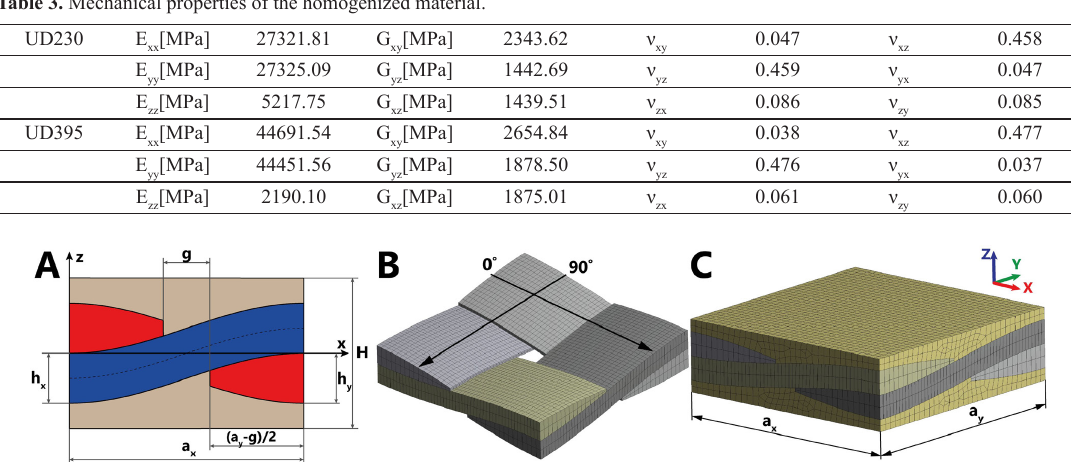
Figure 3. Geometry and FEM models of RVE. A – dimensions of the plain weave. B – weave pattern present in the RVE. Different threads orientations are marked with arrows. C – full FEM model of RVE consisting of four threads and a matrix.